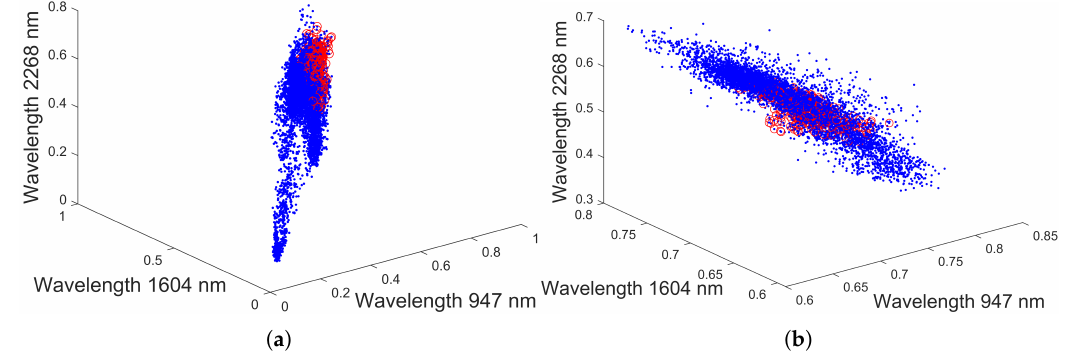
Figure 12. Scatterplot of the whole drill core sample (blue dots) and the MLA region (red circles); without ( a ) and with ( b ) normalization.